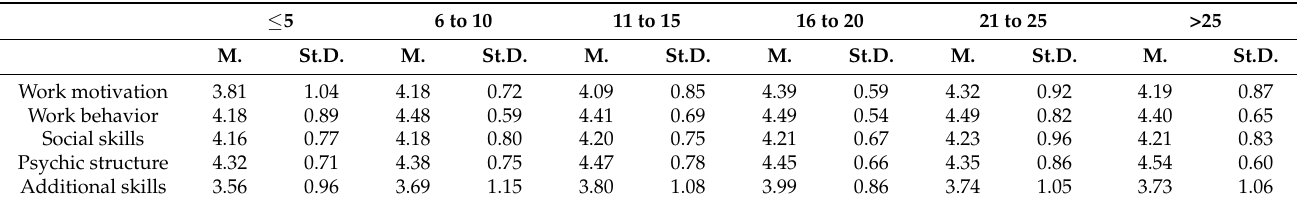
Table 15. Means (M.) and standard deviations (St.D.) of the overall answers of the different scales of the questionnaire when the sample is differentiated by years of teaching experience.